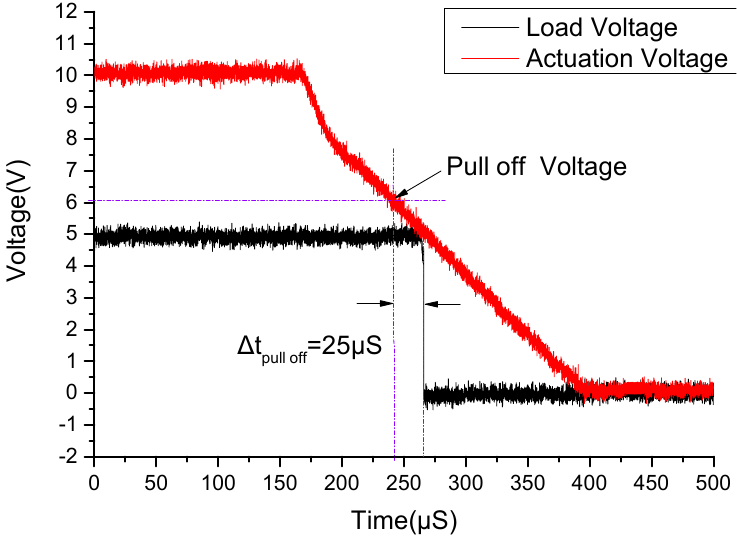
Figure 12. The measured switching-off time of the proposed MEMS relay.